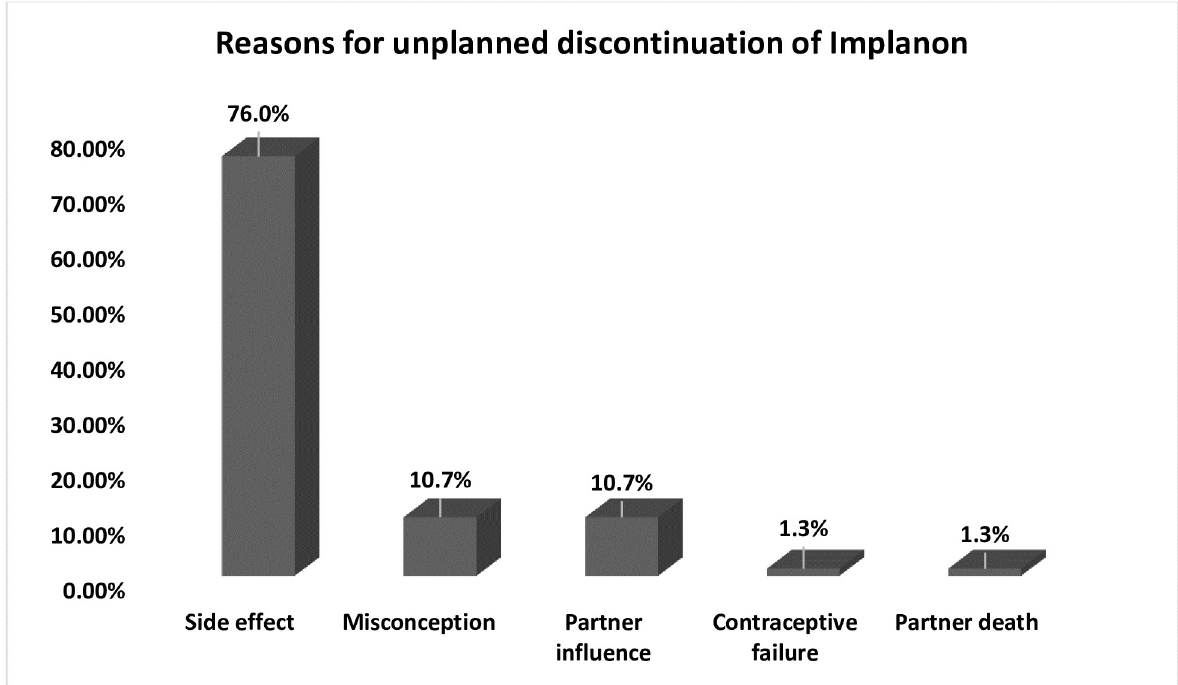
Fig 2. Reasons for the unplanned discontinuation of Implanon at Ayder comprehensive specialized hospital, Mekelle, Northern Ethiopia, 2016–2017 (n =